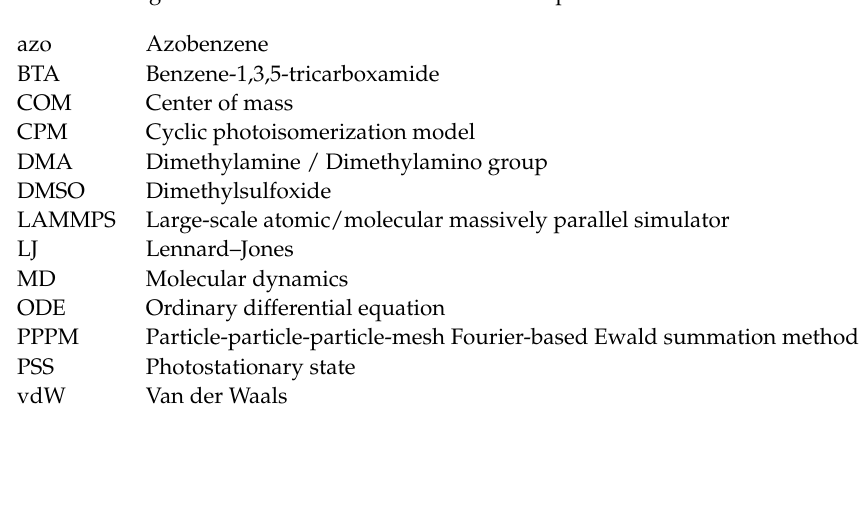
Figure S1: Number of hydrogen bonds per neighboring pair over the course of the CPM simu- lations, Figure S2: Decomposition of the average intermolecular energy between adjacent pairs of monomers based on the interactions between the different parts of the TrisAzo molecules, Figure S3: Decomposition of the average intermolecular energy between adjacent pairs of monomers based on the different types of non-covalent interactions, Figure S4: Time evolution of the intermolecular energies of the full TrisAzo stack, Section S2: Mathematical Model of the Isomer Interconversion, Section S3: Descriptors of the Cluster